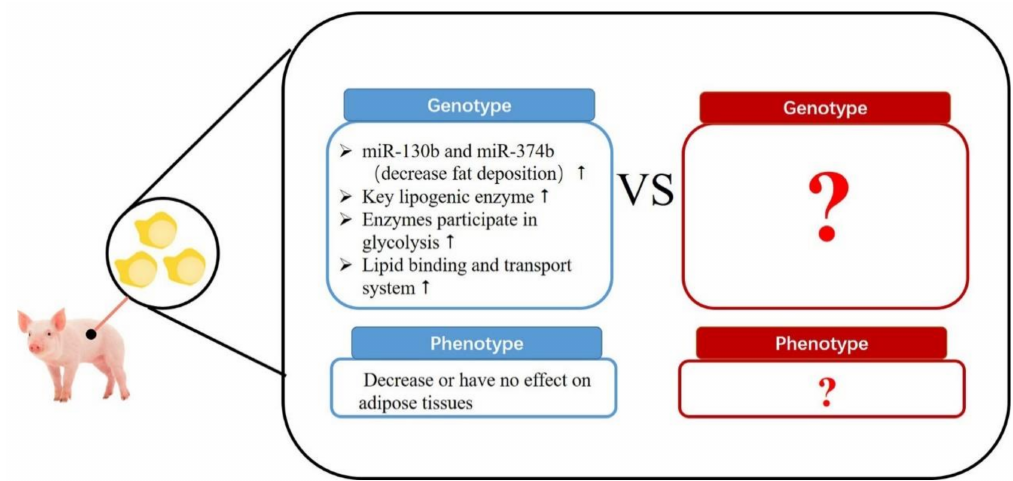
Figure 3. Effects of deficient and excess maternal protein level on neonate fat formation. Upward-pointing arrow indicates “increase” and downward-pointing arrow indicates